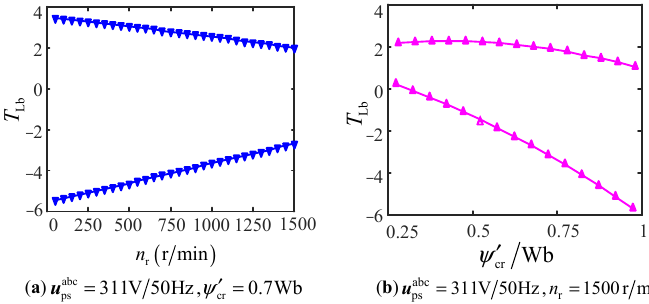
Figure 6. The bounds of the load torque when speed and CM rotor flux vary. Table 2. The boundaries of load torque at